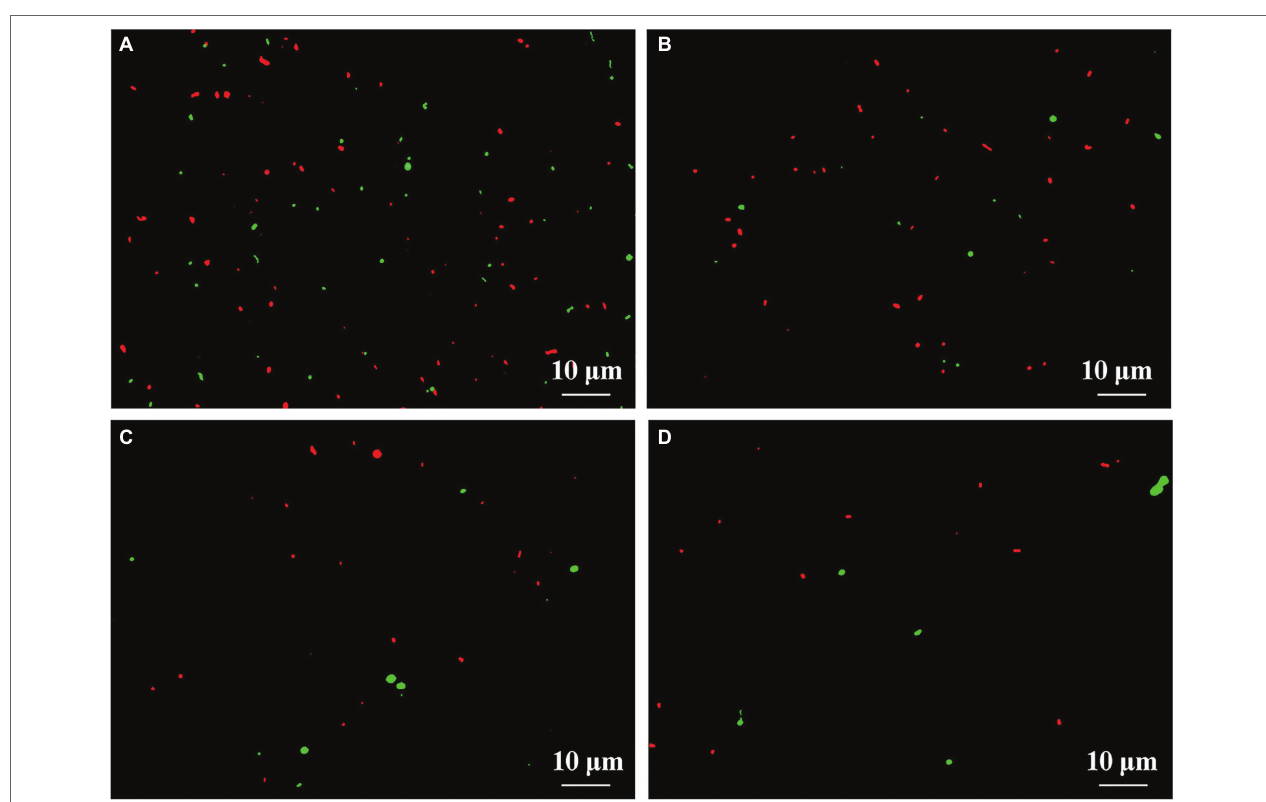
FIGURE 4 | Effect of ZnONP on number of gut bacteria from healthy and ADHD children by live-dead staining. (A) Healthy; (B) healthy + ZnONP; (C) ADHD; and (D) ADHD + ZnONP.